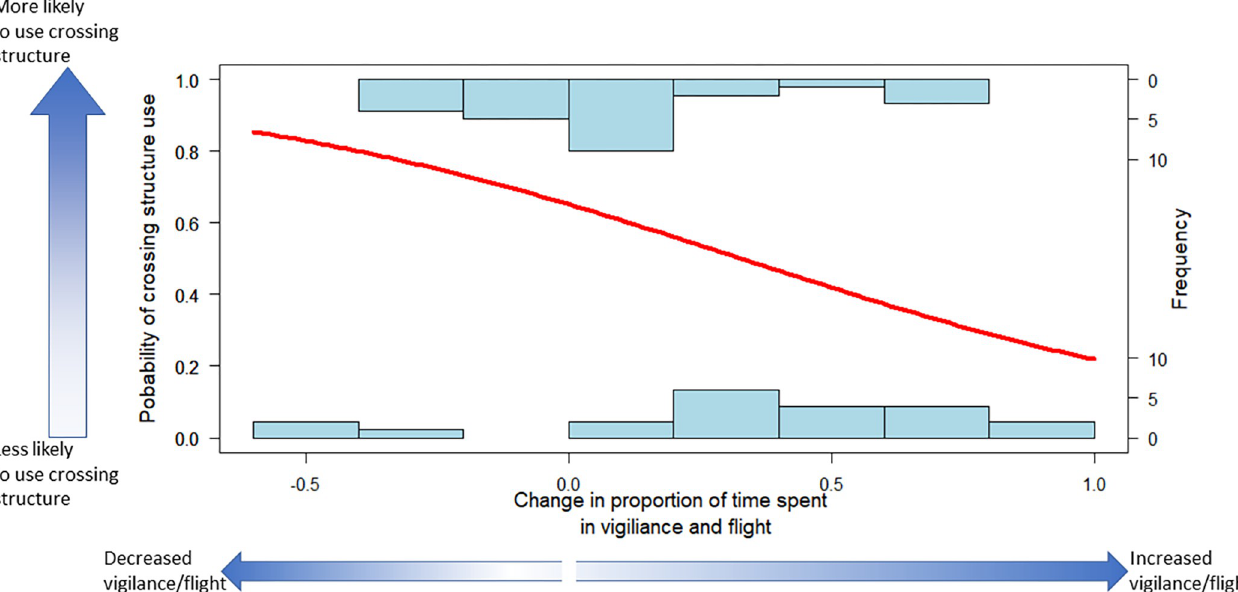
Fig 3. Results from logistic regression depicting variation in the probability of elk and deer crossing a road as a function of time allocated to vigilance & flight responses. Values, on the X-axis larger than zero indicate an increase in vigilance and flight behavior after vehicle passage (i.e., proportion of time spent on vigilant/flight behaviors after a vehicle passes minus the proportion of time spent on vigilant/flight behaviors before a vehicle passes). Larger values on the “probability of crossing” Y-axis, and the corresponding line in the figure, indicate increased probability of using a crossing structure. Deer and elk individuals are less likely to use a crossing structure after demonstrating vigilant/flight behavior in response to a vehicle. The “frequency of crossing” Y-axis shows the distribution of vigilance/flight in animals that either used the wildlife crossing structure (top) or those that did not use the crossing structure (bottom).